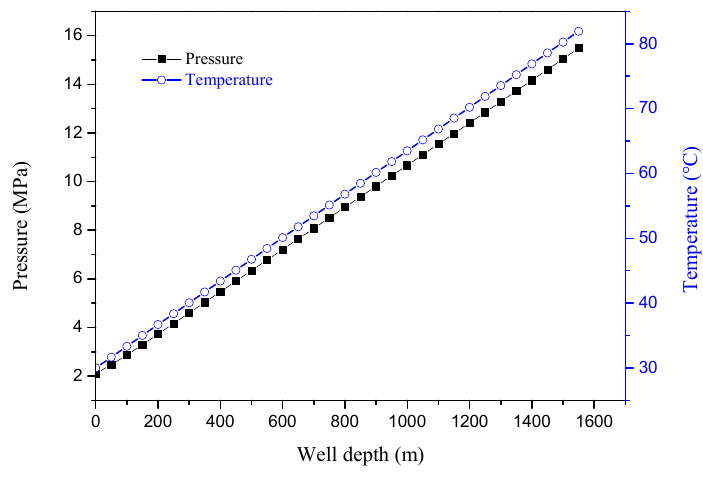
Figure 3. Distribution of temperature and pressure as a function of well depth.